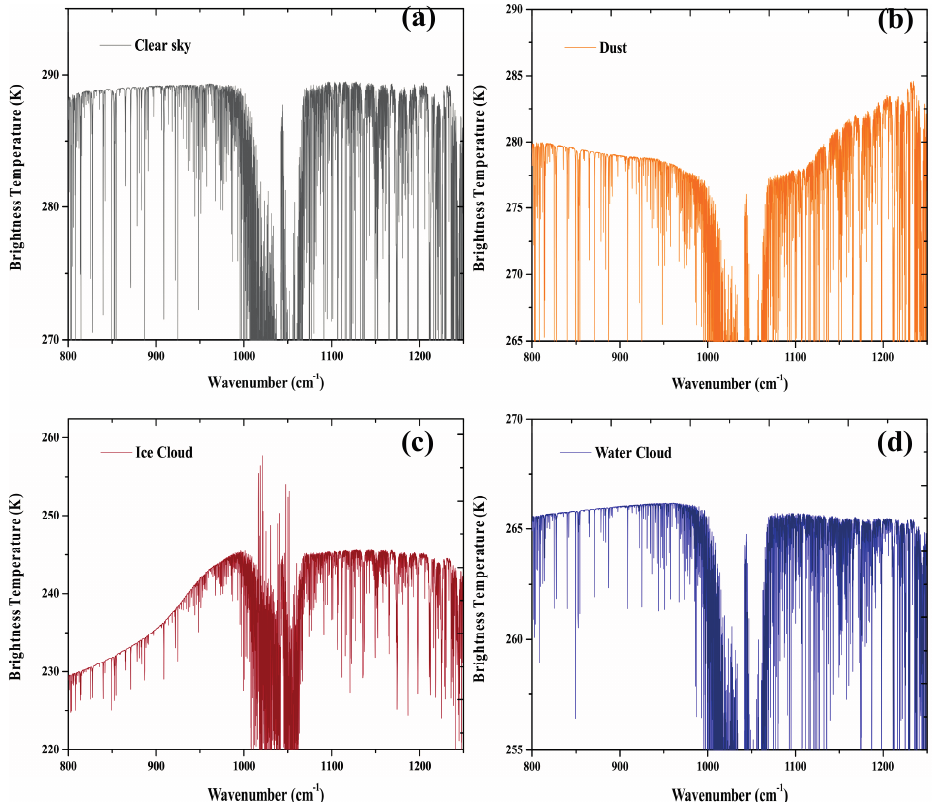
Figure 1. The simulated nadir-viewed spectral brightness temperatures under the conditions of ( a ) clear sky, ( b ) dust, ( c ) ice cloud and ( d ) water cloud. For the microphysical description of dust, the size distribution is assumed as accumulated mode [44] specified in terms of lognormal function, and its standard deviation is 2.0. The refractive indices are taken from dust-like [45], due to its better depiction of Asian dust optical properties [46]. Microphysical models of water and ice cloud are derived from LibRadtran software dataset [47]. The size distribution of water cloud particle is assumed as gamma function, its standard deviation is 7.0, and the refractive indices of water cloud are assumed as liquid water. The optical properties of ice cloud [48,49] are calculated from various ice crystal habits based on the in-situ horizontally averaged particle size distributions obtained from a variety of field campaigns in both mid-latitude and tropical locales. Specially, mixed-phase cloud is not considered in the current study as relationships of parameters within mixed-phase clouds are complicated and generally poorly correlated